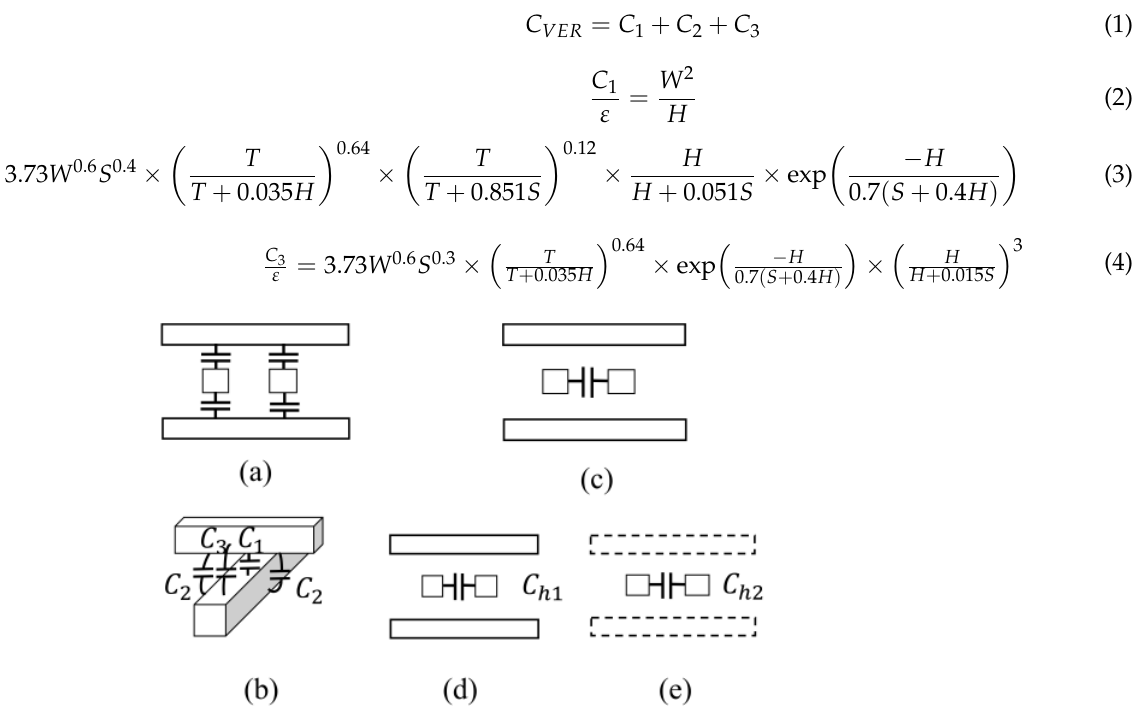
Figure 4. Breakdown of the capacitor; vertical capacitance components ( a , b ) and horizontal capaci- tance components ( c – e